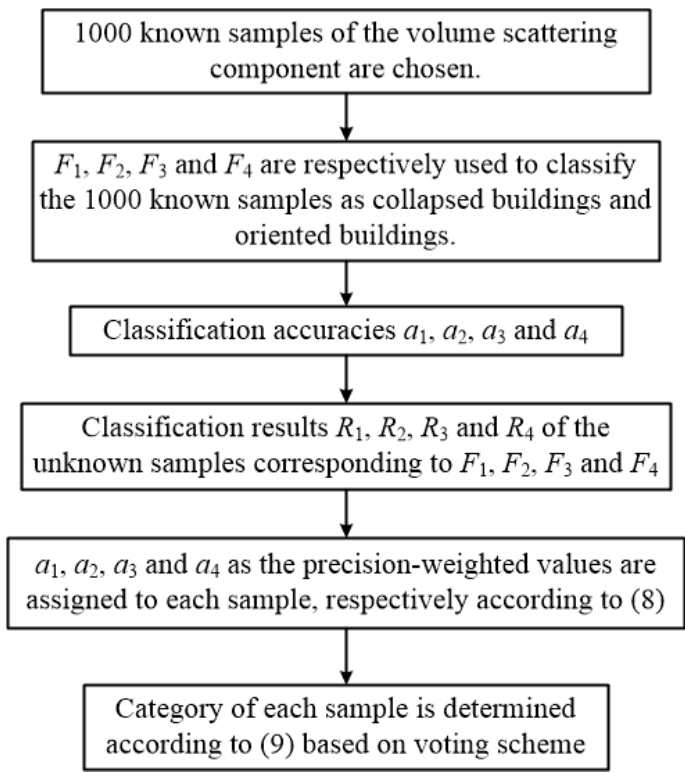
Figure 7. The flowchart of discerning CB and OB using the PWMF method.